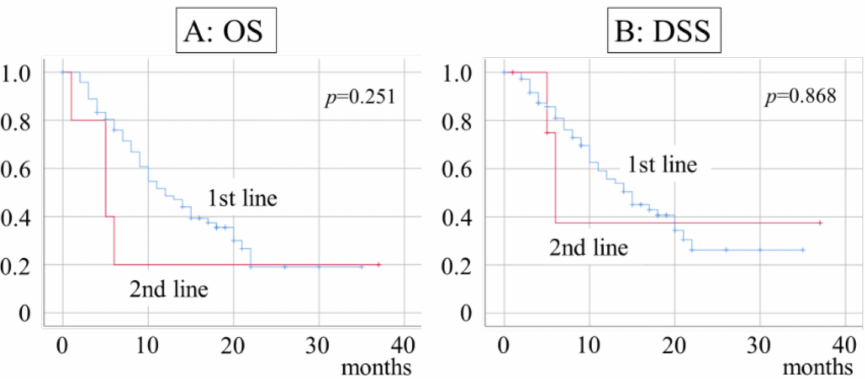
Figure 2. Survival rate and timing of RT and CET therapy. ( A ) Median OS duration is 12 months in first-line and 5 months in second-line patients; ( B ) median DSS duration is 15 months in first-line and 6 months in second-line patients.